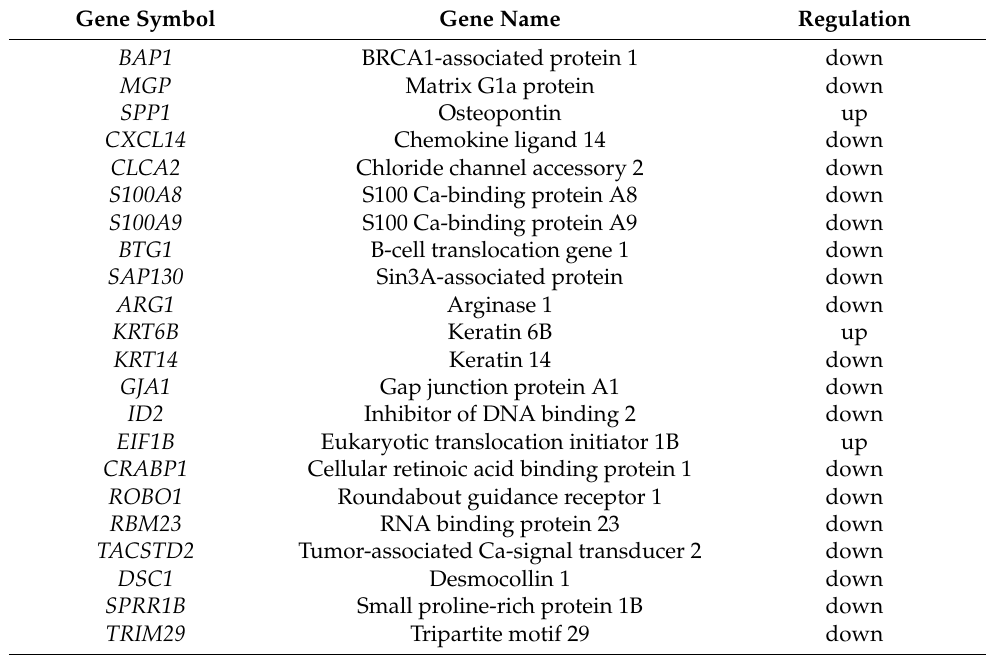
Table 4. DecisionDx prognosticator of melanoma: list of genes to be evaluated [34]. Gene